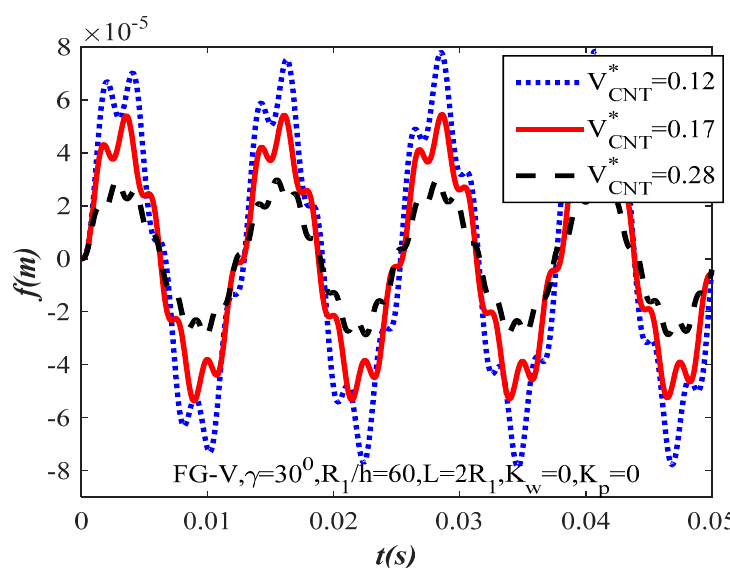
Figure 4. Effect of volume fraction of fibers on the dynamic response of the FG-CNTRC truncated conical shells.